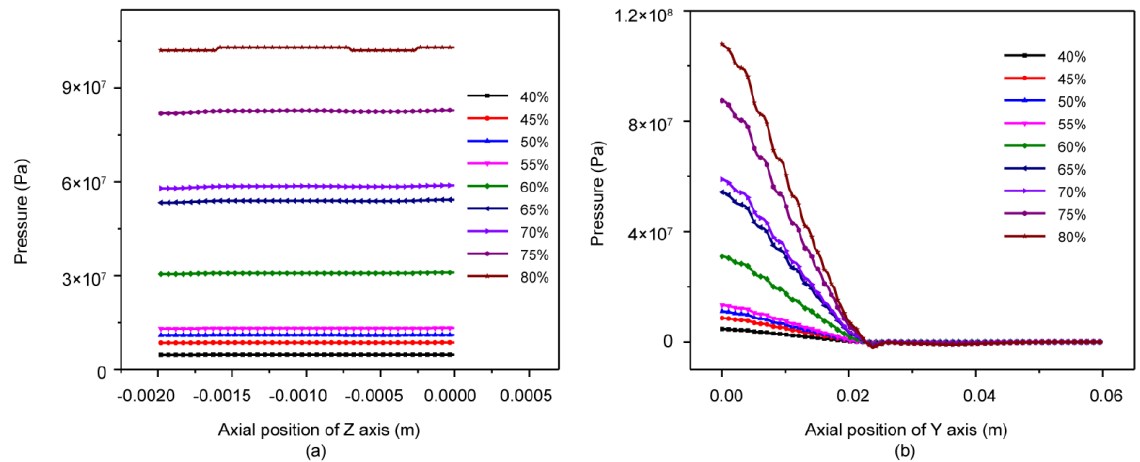
Figure 7. Centerline pressure distribution along the ( a ) z -axis and ( b ) y -axis.